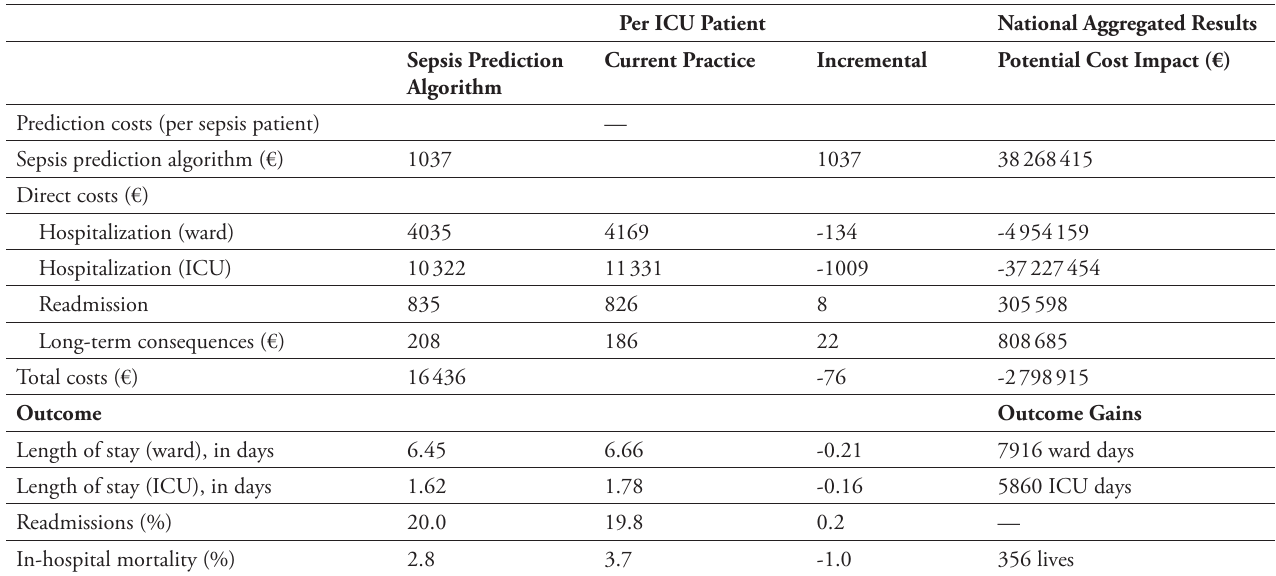
Table 3. Model Base Case Results